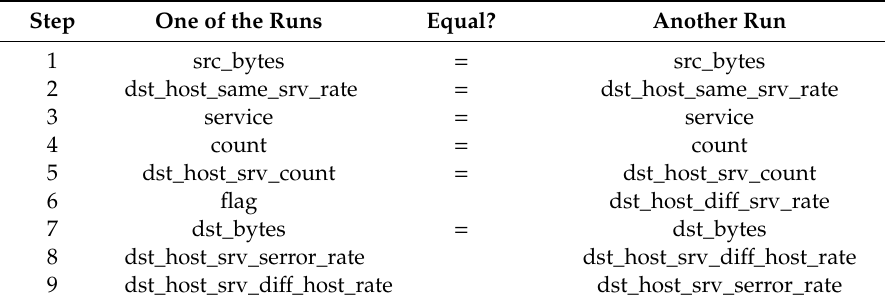
Table 7. The smallest feature combinations—NSL-KDD dataset. For each step, the features that were selected at that step in two shortest runs are listed for the newly proposed method. Note the equality of selected features in several